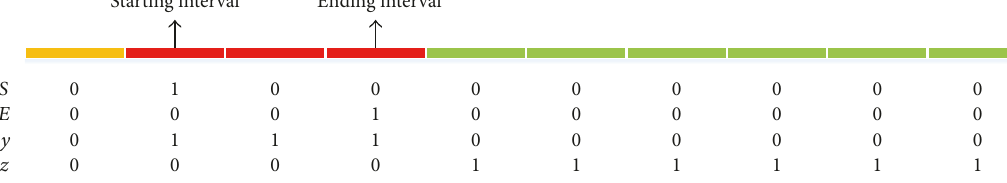
Figure 2: An example to illustrate the values of 𝑆 𝑎,𝑚 , 𝐸 𝑎,𝑚 , 𝑦 𝑎,𝑚 , and 𝑧 𝑎,𝑚 throughout the entire planning horizon.